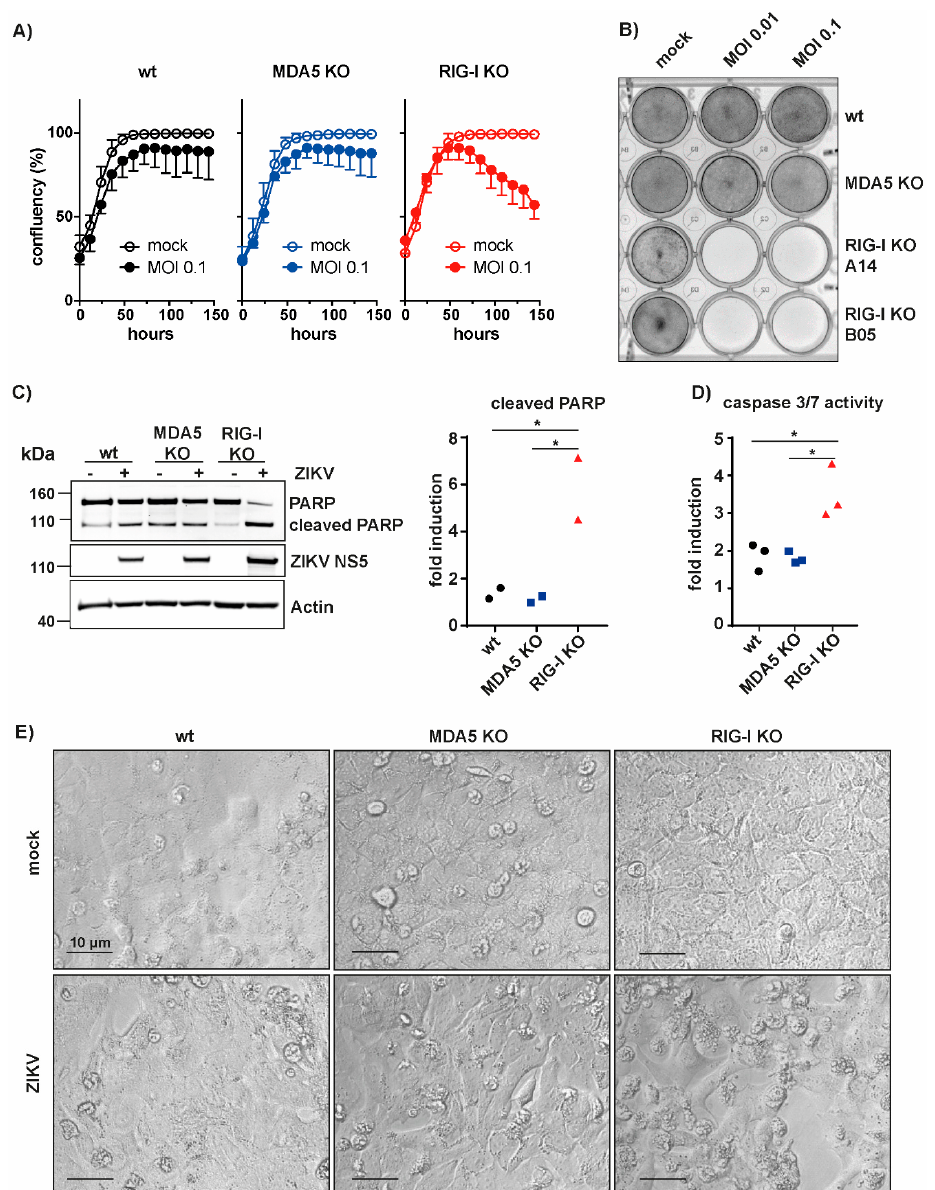
Figure 3. RIG-I signaling protects A549 cells from ZIKV-induced cell death. ( A ) A549 cells were infected with ZIKV (MOI 0.1) and cell confluency was measured for 6 days in the Incucyte; ( B ) A549 cells were infected with ZIKV, fixed 6 days after infection and stained with crystal violet; ( C ) A549 cells were infected with ZIKV (MOI 0.1) and lysed 4 days after infection. Cell lysates were analyzed by western blot using the indicated antibodies (left). Actin served as a loading control. Signal intensity of full length and cleaved PARP was quantified relative to background and the fold induction of cleaved PARP was calculated (right); ( D ) A549 cells were infected with ZIKV (MOI 0.1) and the activity of caspase 3 and 7 was determined 4 days after infection using the Promega Caspase-3/7 Glo assay; ( E ) A549 cells were infected with ZIKV (MOI 0.1) and images were acquired 4 days after infection. Scale bar: 10 μ m. Data in A , C (right) and D are pooled form two ( C ) or three ( A , D ) independent experiments. In A , mean and SD are plotted; in C and D , data points correspond to individual experiments and statistical analysis was with one-way ANOVA with Tukey’s multiple comparison (* p < 0.05). Data in B , C (left) and E are representative of two ( C ) or three independent experiments ( B , E